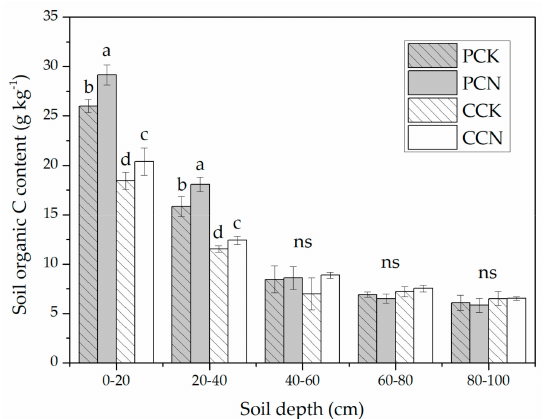
Figure 1. Soil C content at di ff erent depth in the four plantations (mean ± standard error, n = 4). PCK, PCN, CCK, and CCN represent the pure and near natural managed P. massoniana plantation and the pure and near natural managed C. lanceolata plantation, respectively. Values with di ff erent letters indicate significant plantation e ff ects at p < 0.05. Data collected in 2016 are shown. ns, p > 0.05.